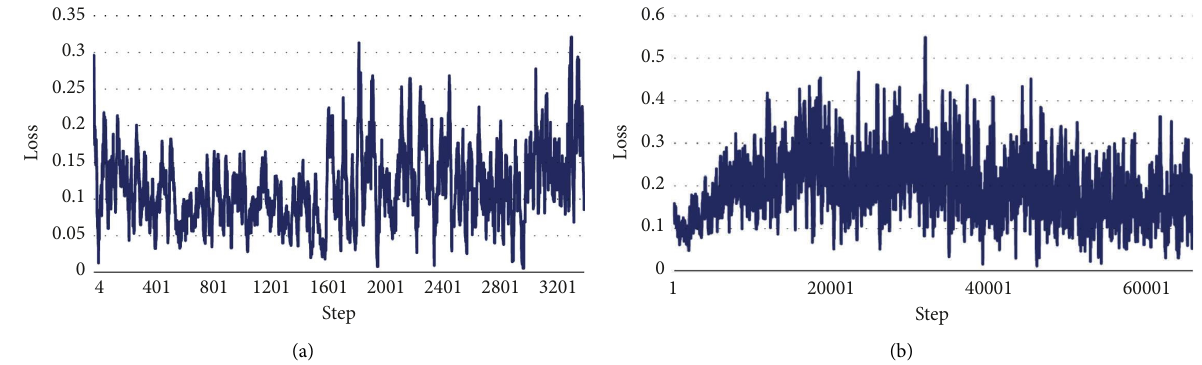
Figure 4: Training loss of DQN-based decision model of ADV.(a) 4000 steps. (b) 65000 steps.